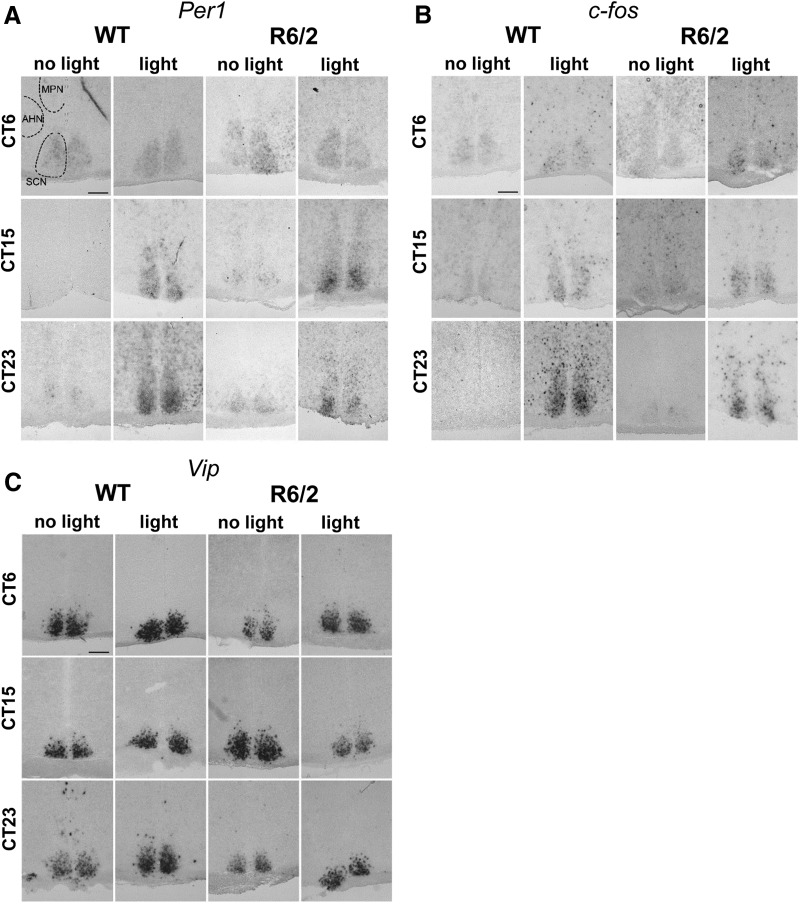
Expression of Per1 and c-fos in the SCN induced by a single light pulse in WT and R6/2 mice. A–C, Representative photomicrographs show mRNA expression in the SCN by in situ hybridization of Per1 (A), c-fos (B), and Vip (C) in 14-week-old R6/2 and WT mice under DD or 45 min after a light pulse (15 min, 300 lux minimum) at CT6, CT15, or CT23. The SCN, medial preoptic nucleus (MPN), and anterior hypothalamic nucleus (AHN) are indicated with dashed outlines. Scale bar, 200 μm.